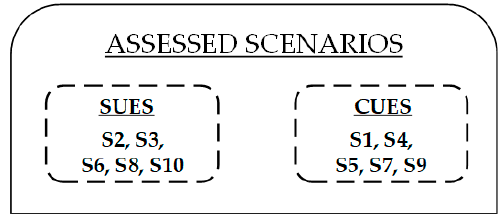
Figure 5. Classification of assessed scenarios.